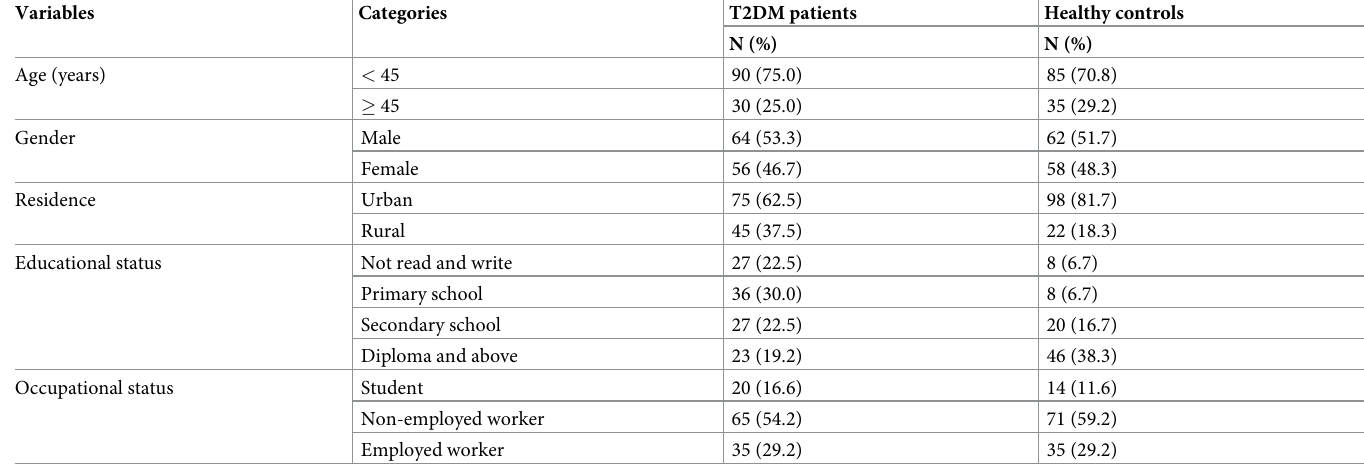
Table 1. Sociodemographic characteristics of study participants at Dessie comprehensive specialized hospital, Northeast Ethiopia from January to June 2021 (n = 240).